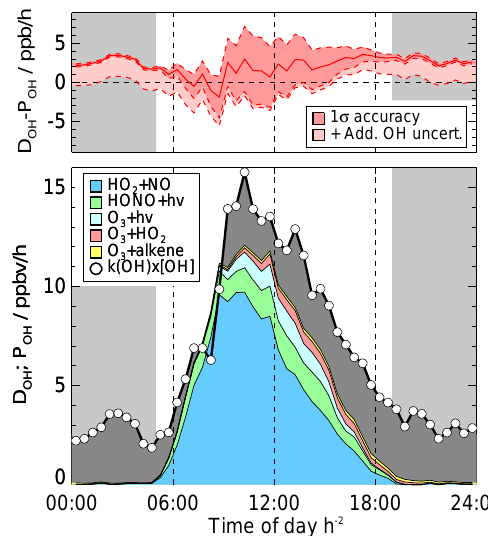
Figure 9. Median diurnal profiles of OH production ( P OH ) and de- struction ( D OH ) rates. Data are only included if all required trace gas concentrations and OH reactivity were measured concurrently. Dark gray areas indicate missing OH production. The upper panel gives the 1 σ accuracy of the difference ( D OH − P OH ) calculated from the uncertainties of measurements (Gaussian error propaga- tion). The effect on the accuracy from an upper limit of potential interferences in the OH measurements is shown